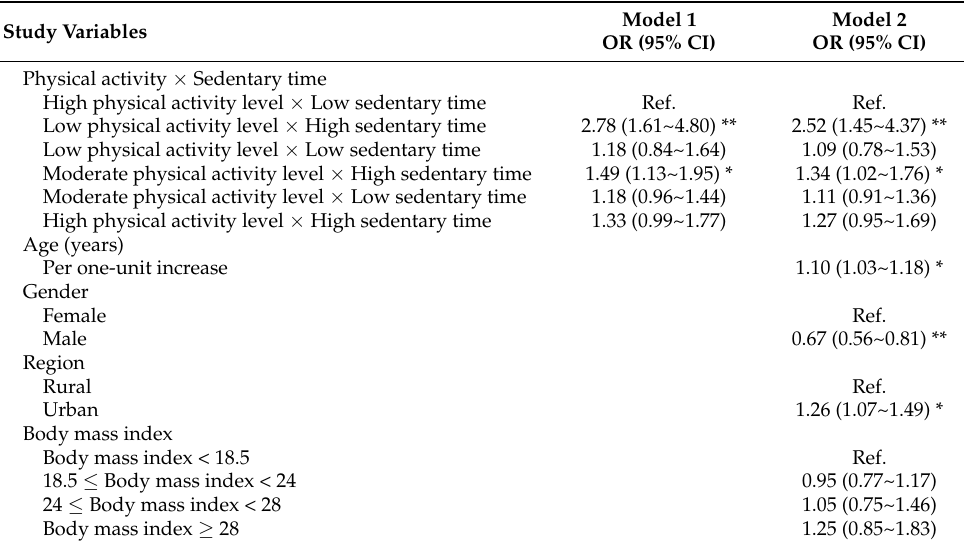
Table 4. Combined associations between physical activity and sedentary time with poor sleep quality among college